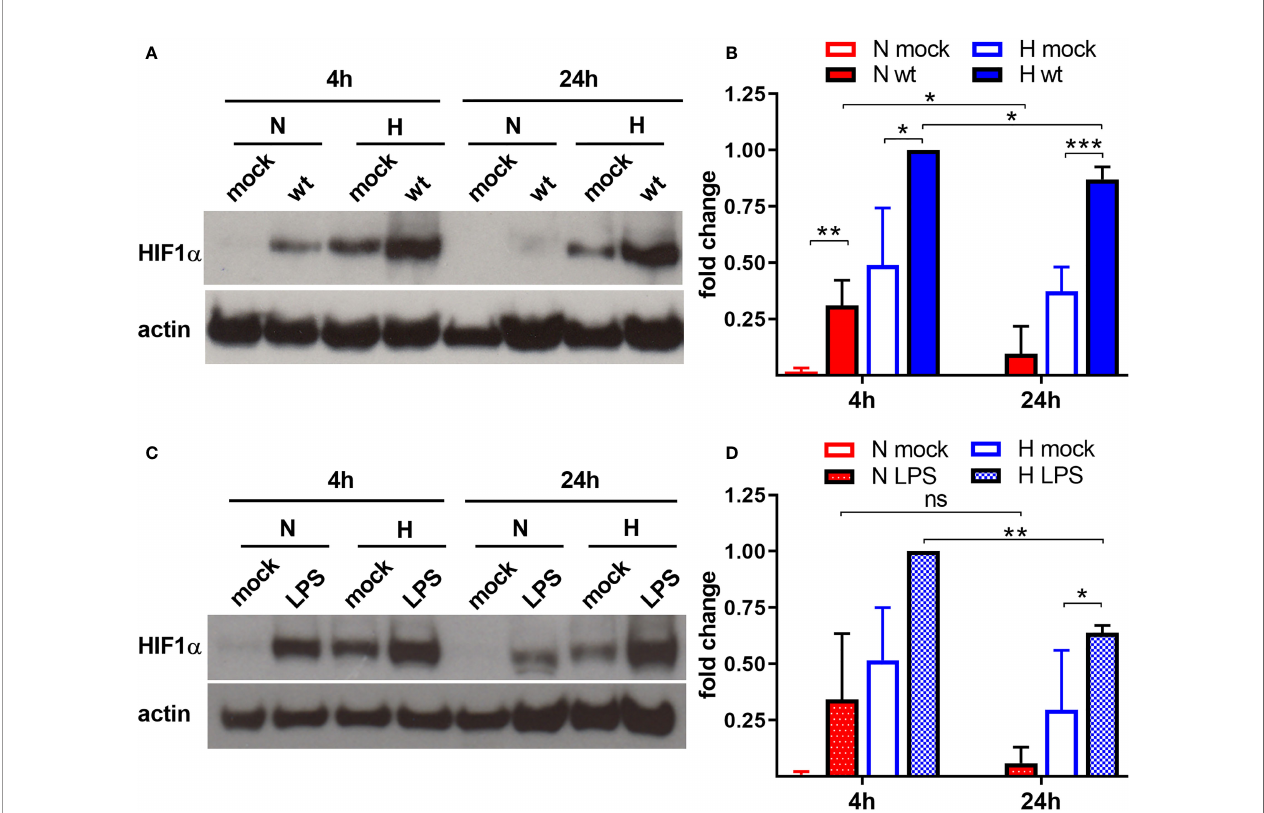
FIGURE 1 | C. burnetii and LPS boost HIF1 a stabilization. (A, B) Murine BMDM either uninfected (mock) or infected with C. burnetii (wt) for 4 and 24 h under normoxia (N) or hypoxia (H) were analyzed by immunoblot analysis using antibodies against HIF1 a and actin as loading control. (A) One representative experiment out of four independent experiments is shown. (B) Densitometric analysis of the HIF1 a /actin ratio was performed using ImageJ. Fold changes are shown relative to cells infected for 4 hours under (H) Mean ± SD, n = 4, one-sample t test or t test. ***p < 0.001, **p < 0.01, *p < 0.05. (C, D) Murine BMDM either untreated (mock) or treated with LPS (100 ng/ml) for 4 and 24 h under N or H were analyzed by immunoblot analysis using antibodies against HIF1 a and actin as loading control. (C) One representative experiment out of three independent experiments is shown. (D) Densitometric analysis of the HIF1 a /actin ratio was performed using ImageJ. Fold changes are shown relative to cells treated with LPS for 4 hours under (H) Mean ± SD, n = 3, one-sample t test or t test. **p < 0.01, *p < 0.05, ns = non-signi fi